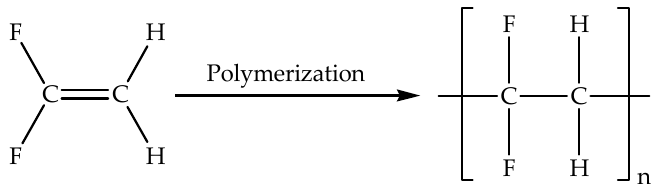
Figure 1. Schematic of the polymerization of vinylidene fluoride to make PVDF.